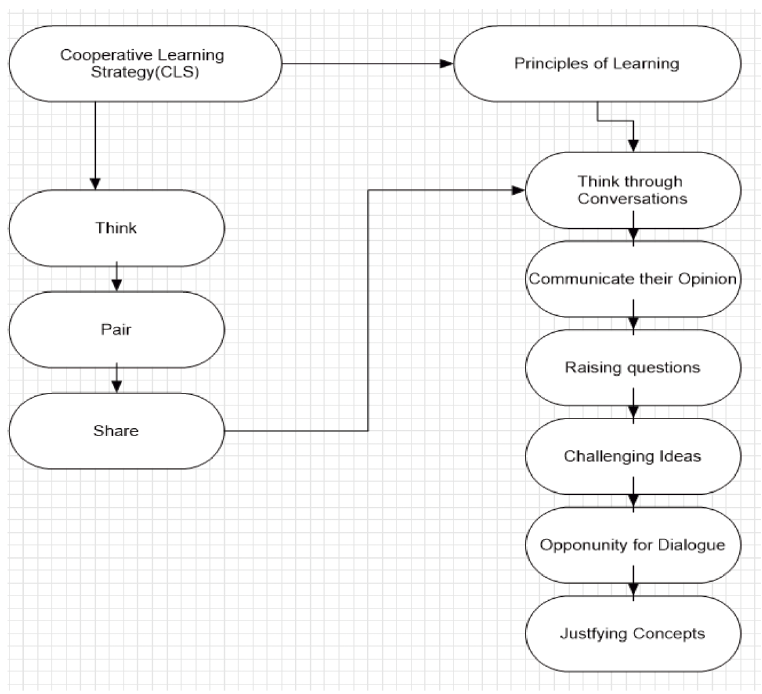
Figure 3. CLS link with principles of learning phases